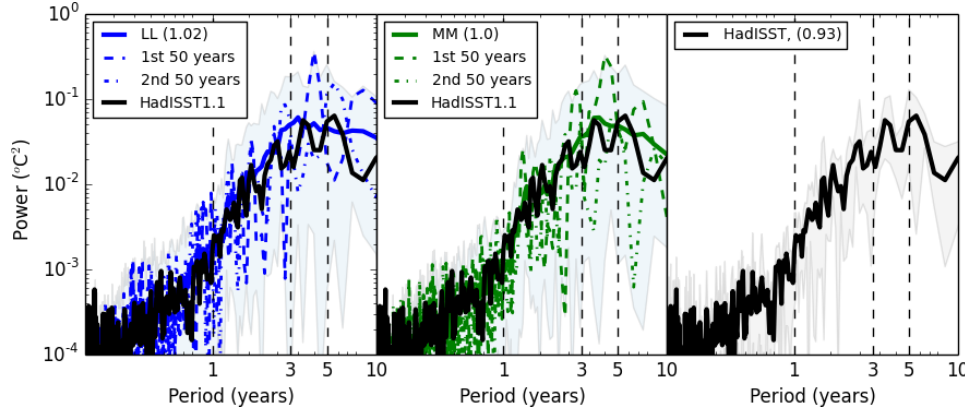
Figure 19. Power spectrum of NINO3.4 surface monthly temperature variability for LL, MM resolution models and HadISST1.1 observa- tions. The coloured line shows the mean power spectrum for all years, the dashed line shows the first 50 years, while the shading shows the range over all 50-year subsampled periods. The number in brackets is the standard deviation of the DJF mean SST in the NINO3.4